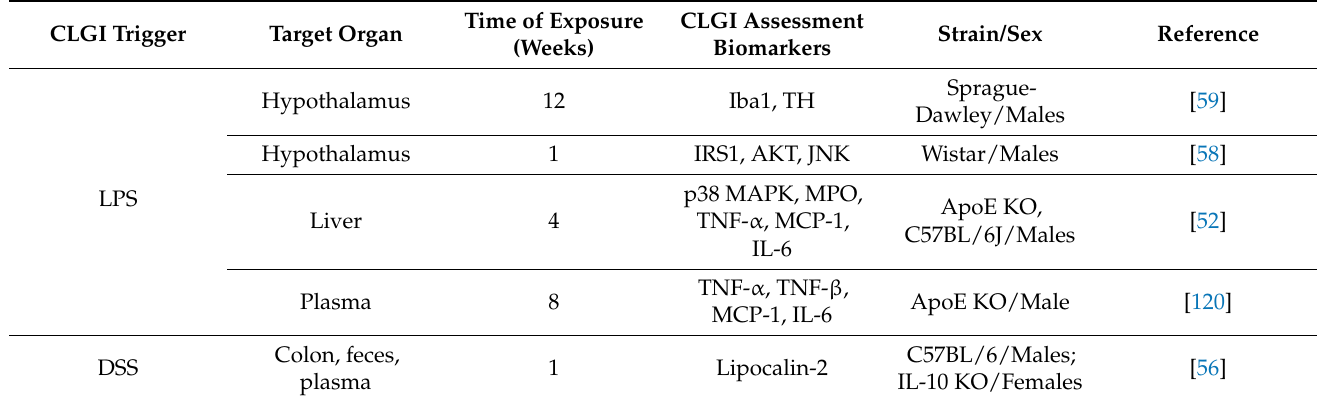
Table 4. Studies of murine gut microbiota and